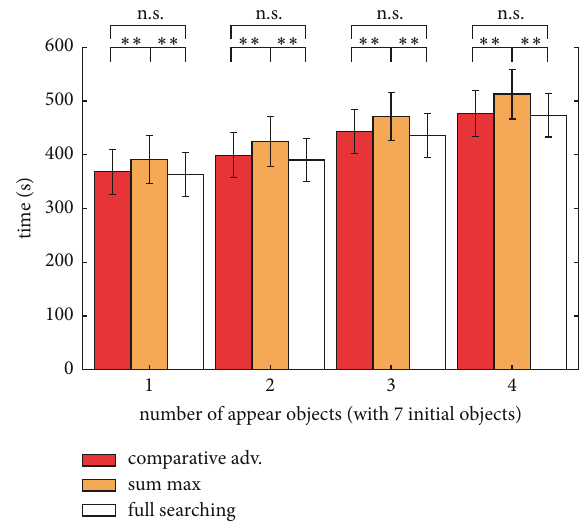
Figure 14: Makespan in the adding condition. ∗∗ 𝑝 < .01 , ∗ 𝑝 < .05 , and + 𝑝 < .1 . A significant 𝑝 value indicates that a significant difference in prescribing exists between the conditions. The lower 𝑝 value indicates a strong significant difference. n.s. means no significant difference between the conditions.